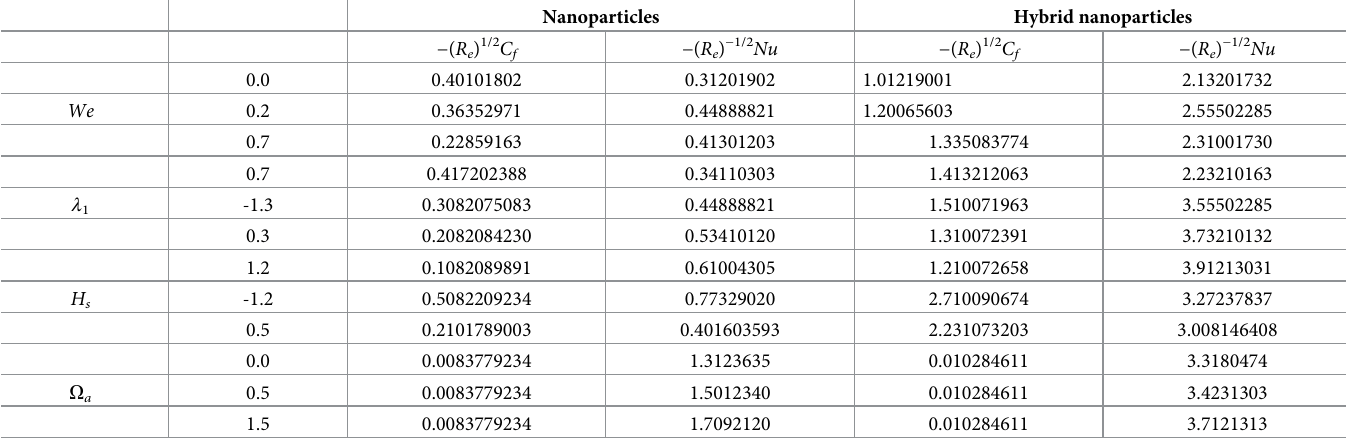
Table 4. Comparative simulations of gradient temperature and skin friction coefficient considering nanoparticles and hybrid nanoparticles versus the change in We , λ 1 , H s and O a